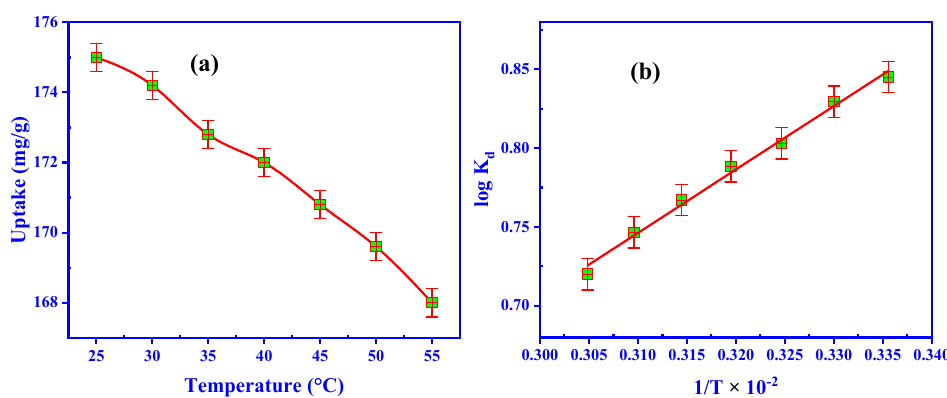
Figure 8. ( a ) Outcome of temperature, and ( b ) relation of log K d vs. 1 /T of adsorption efficiency.